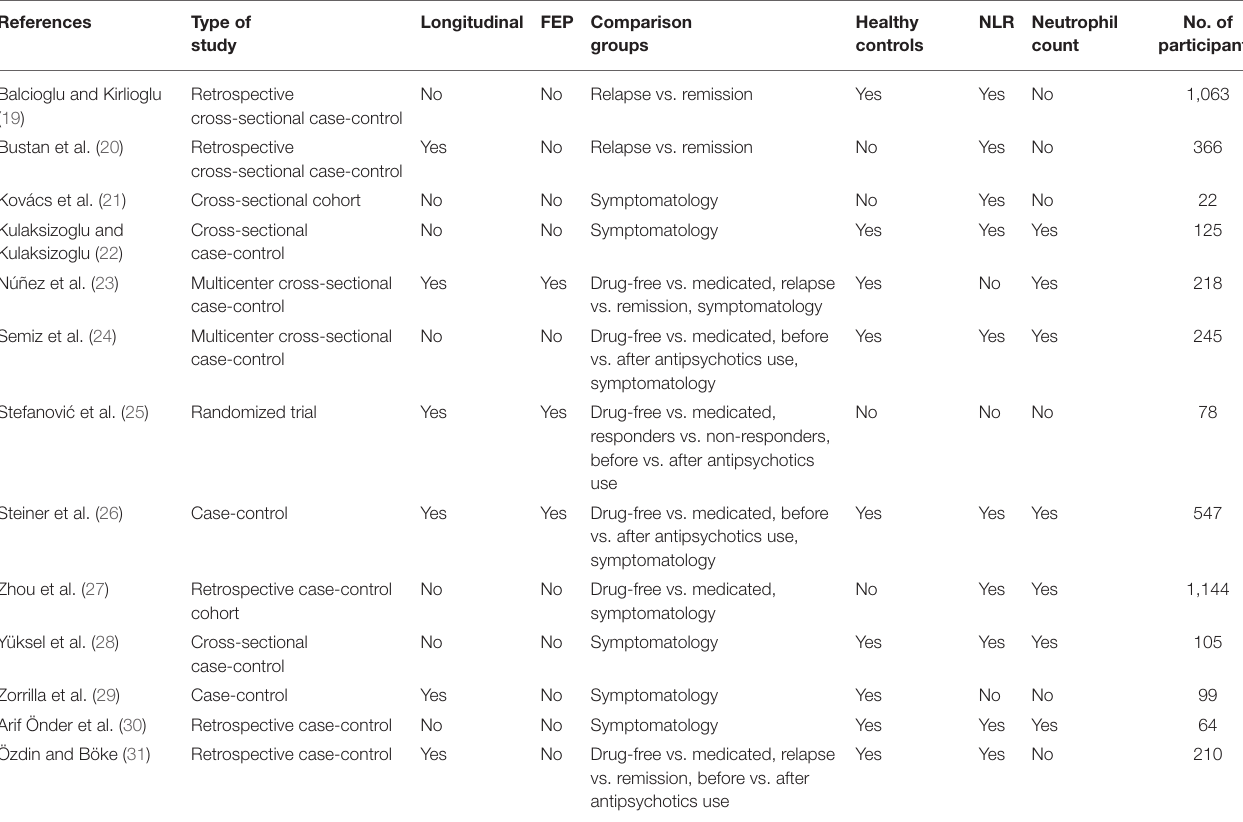
TABLE 1 | Included articles for this scoping review with information about study participants and comparison